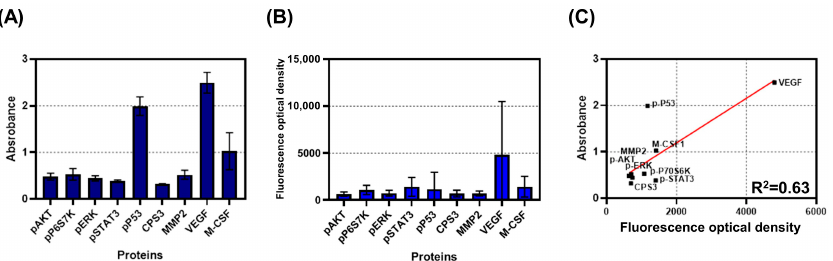
Figure 8. Comparison between bulk and singe-cell assays. ( A ) Protein concentrations from bulk assay are shown. ( B ) Protein concentrations from single-cell assay are shown. ( C ) Linear regression between bulk and single-cell assays is shown; the R 2 value is calculated using this analysis.